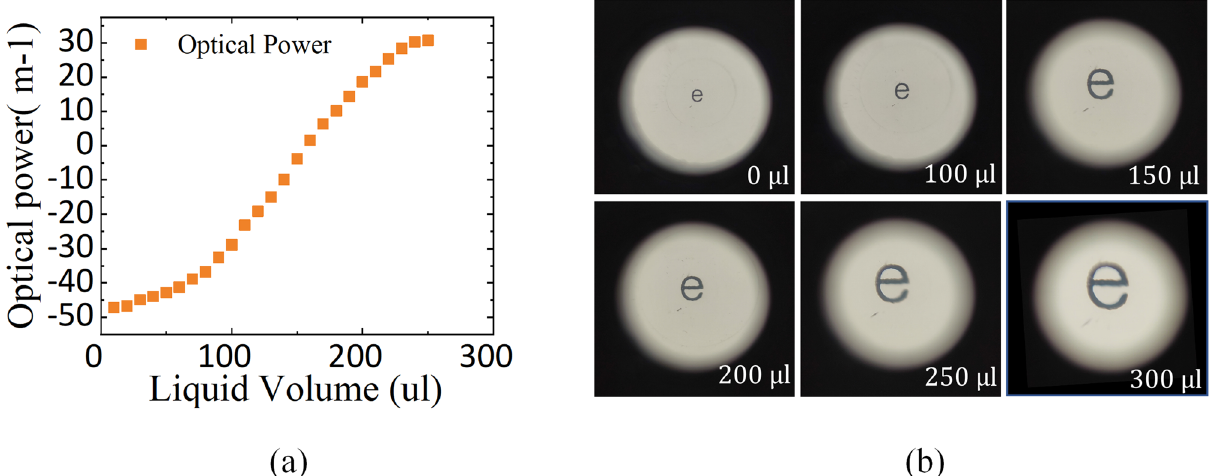
Figure 5. Focusing characteristics of the proposed PDMS lens. ( a ) Correspondence between injected liquid volume and optical power of the proposed PDMS lens. ( b ) Capture imaging of “e” specimen under different liquid